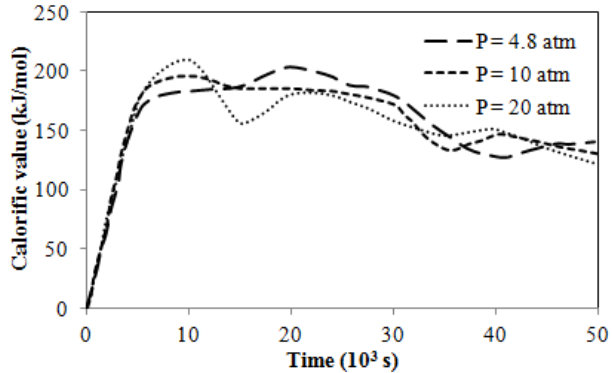
Figure 9. Gas calorific value at different total pressures with time [46].